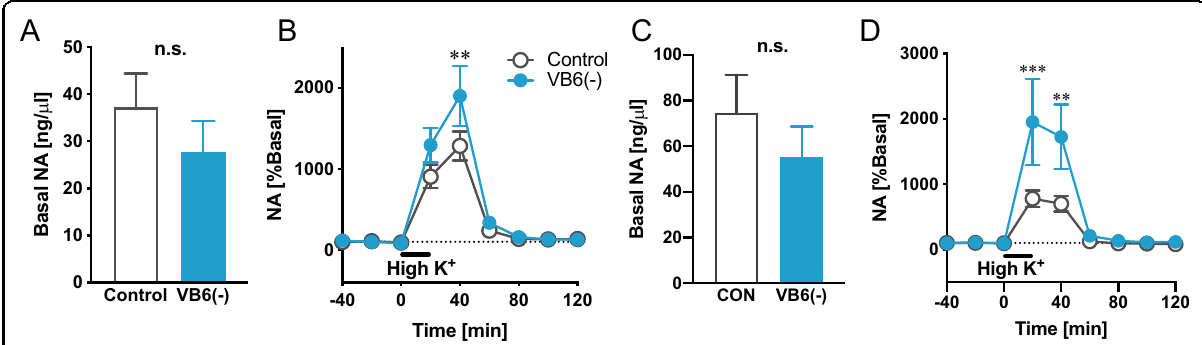
Fig. 3 NA release in the PFC and STR of VB6-de fi cient mice. Basal levels of NA in A the PFC and C the STR are shown. (n.s. using Student ’ s t -test. n = 7). NA release in B the PFC and D the STR were measured. High K + stimulation was performed at the time point of 0 min (Two-way ANOVA with repeated measures: B F Interaction(8,96) = 1.95, p > 0.05; F Time(8,96) = 46.8, p < 0.001; F VB6(1,12) = 3.49, p > 0.05, D F Interaction(8,88) = 3.98, p < 0.001; F Time(8,88) = 19.1, p < 0.001; F VB6(1,11) = 3.98, p > 0.05; **p < 0.01, ***p < 0.001 using Bonferroni ’ s multiple comparison test. n = 7). The data were represented as the mean ± SEM values.